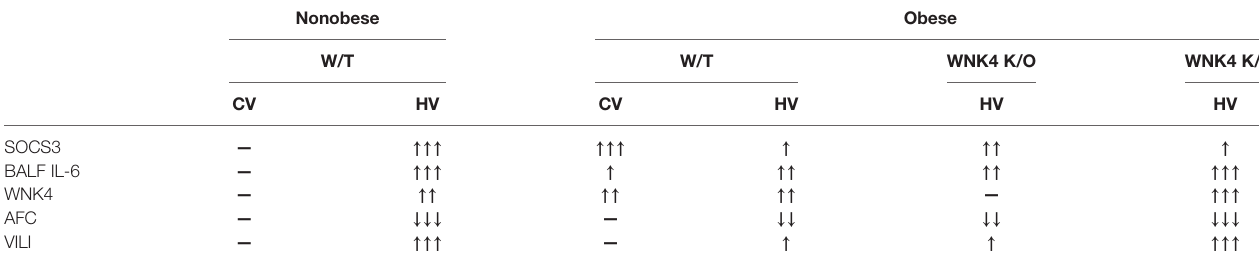
TABLE 1 | Summary table of associated change between SOCS3, in fl ammation, removal of alveolar fl uid, and VILI.